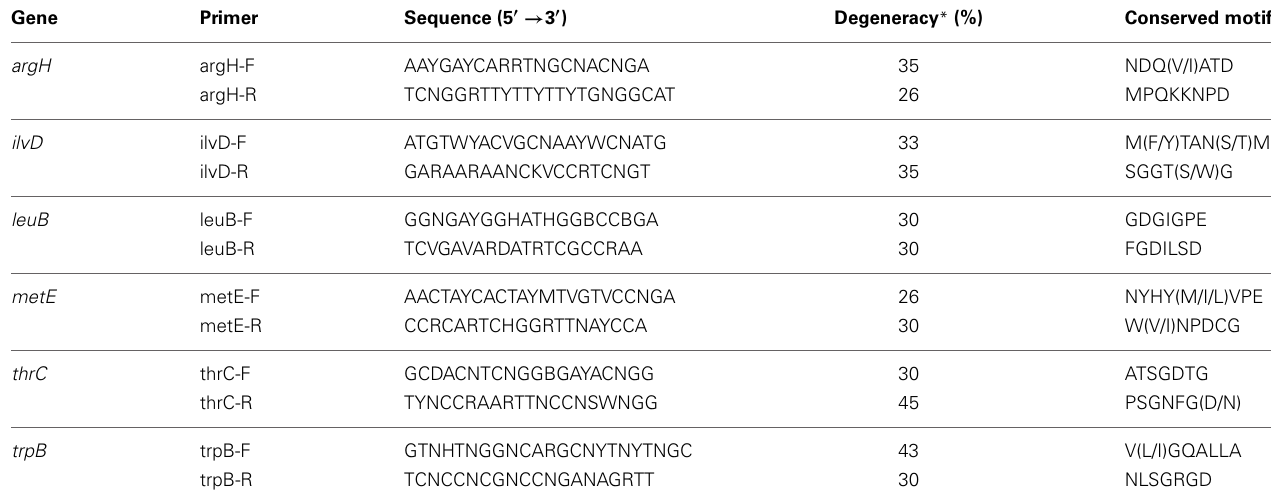
Table 1 | Degenerate primers used in the gene screening.